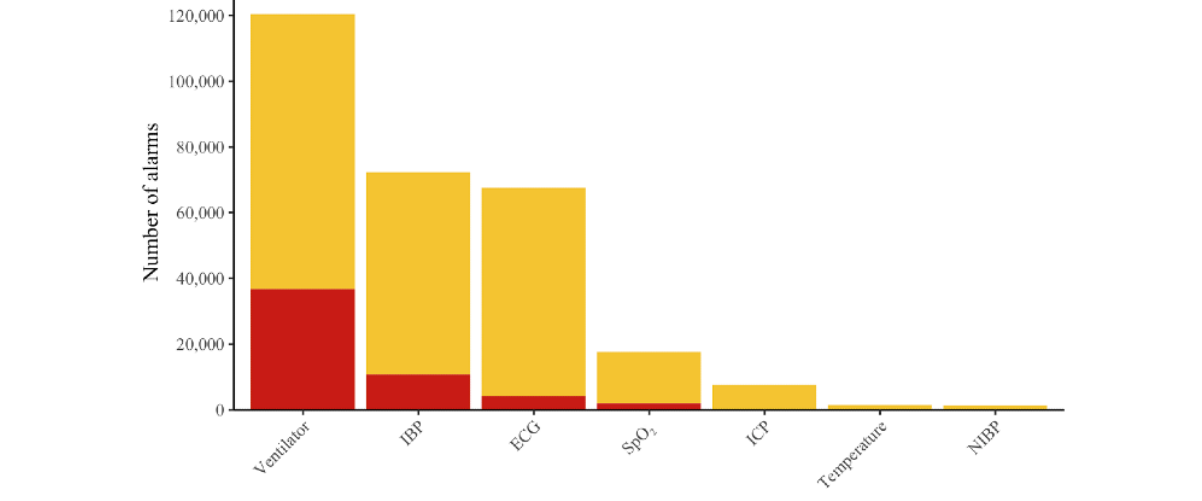
Figure 3. Alarms from medical devices within 93 days subdivided into the criticality levels (red, yellow). ECG: electrocardiogram; IBP: invasive blood